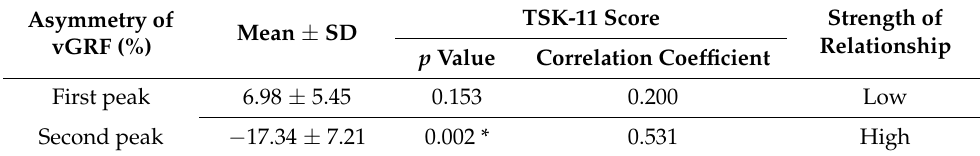
Table 2. Correlations between TSK-11 scores and asymmetry of vGRF during gait.